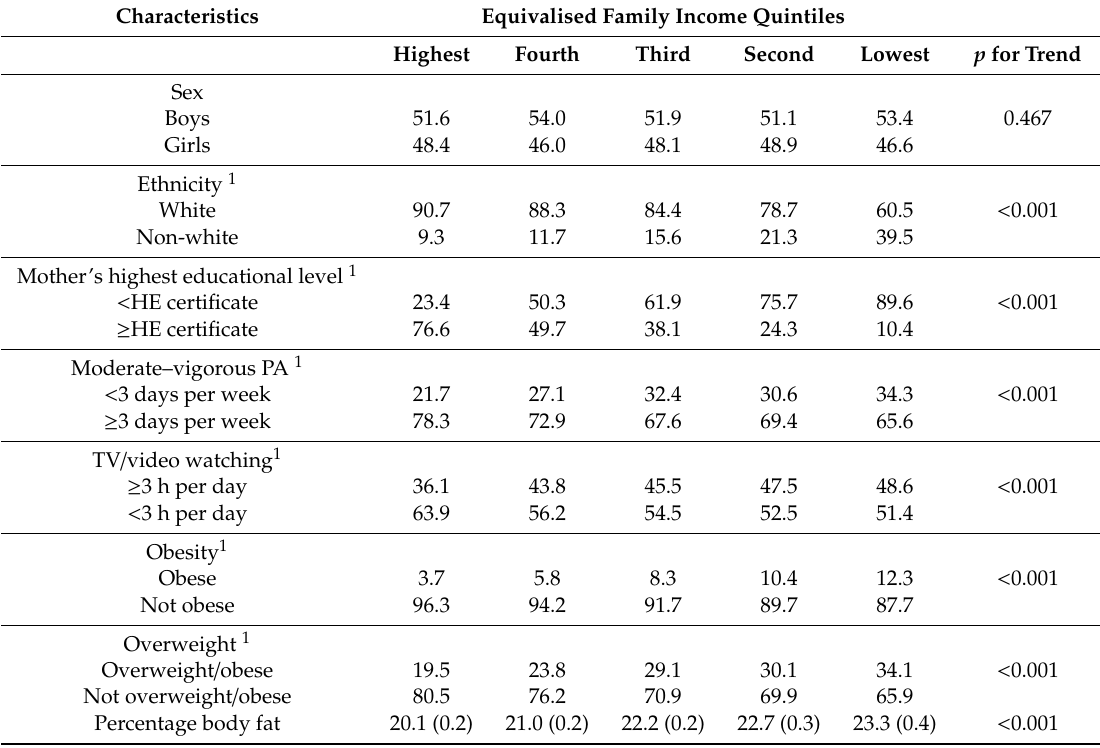
Table 1. Characteristics of study population by equivalised family income quintiles ( N = 11,714).